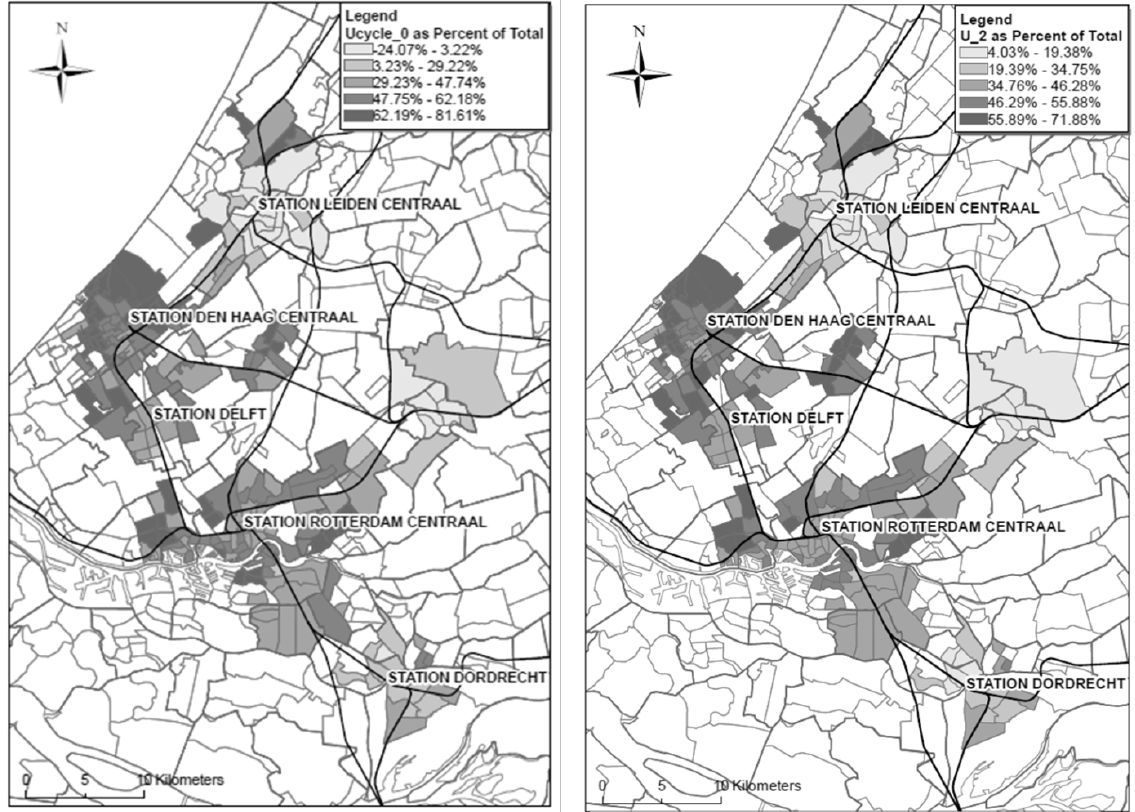
Figure 3. Utilities of accessing the railway station by postcode, calculated with binary and hybrid choice models. Normalization as percentage over the